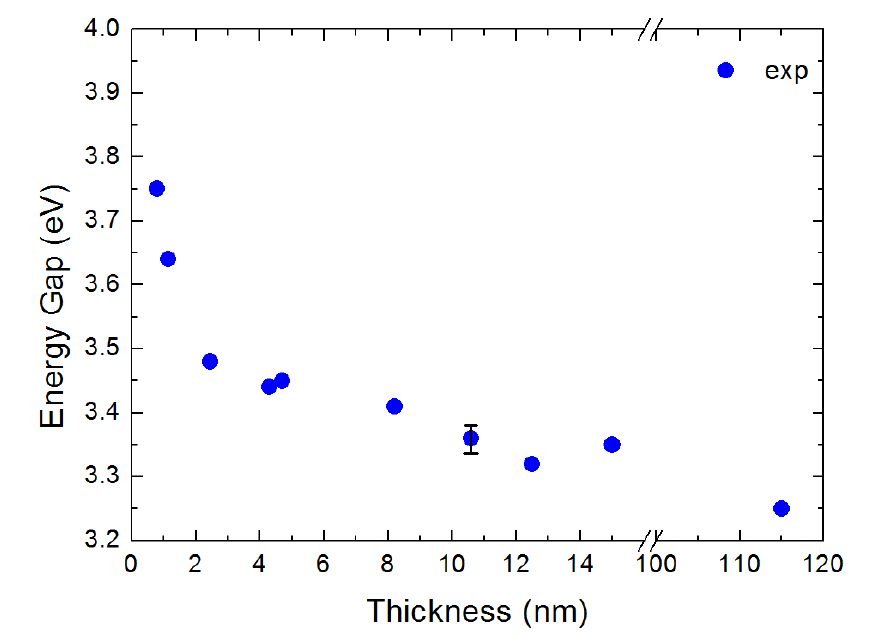
Figure 7. Position of E g as a function of energy. The data reveal a “blue